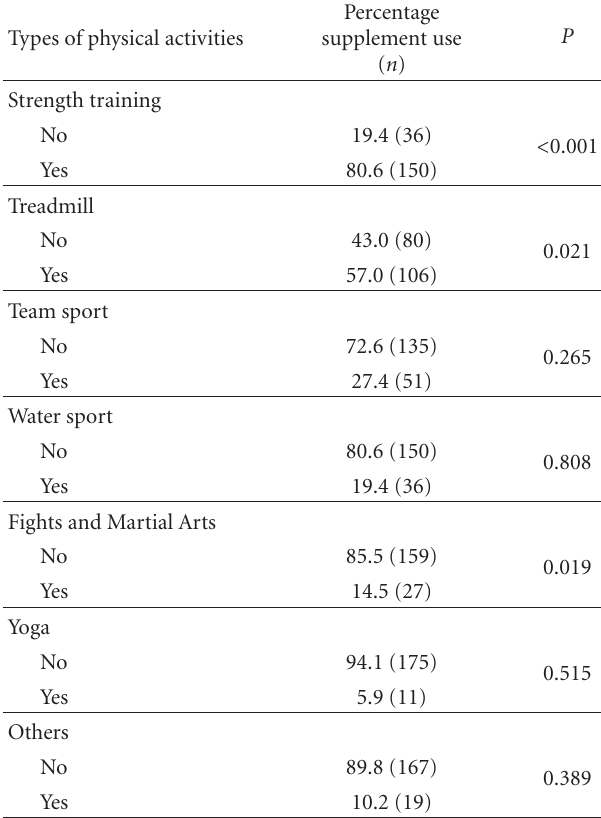
Table 2: Types of physical activities performed in the gyms by supplement users ( n = 186). No missing